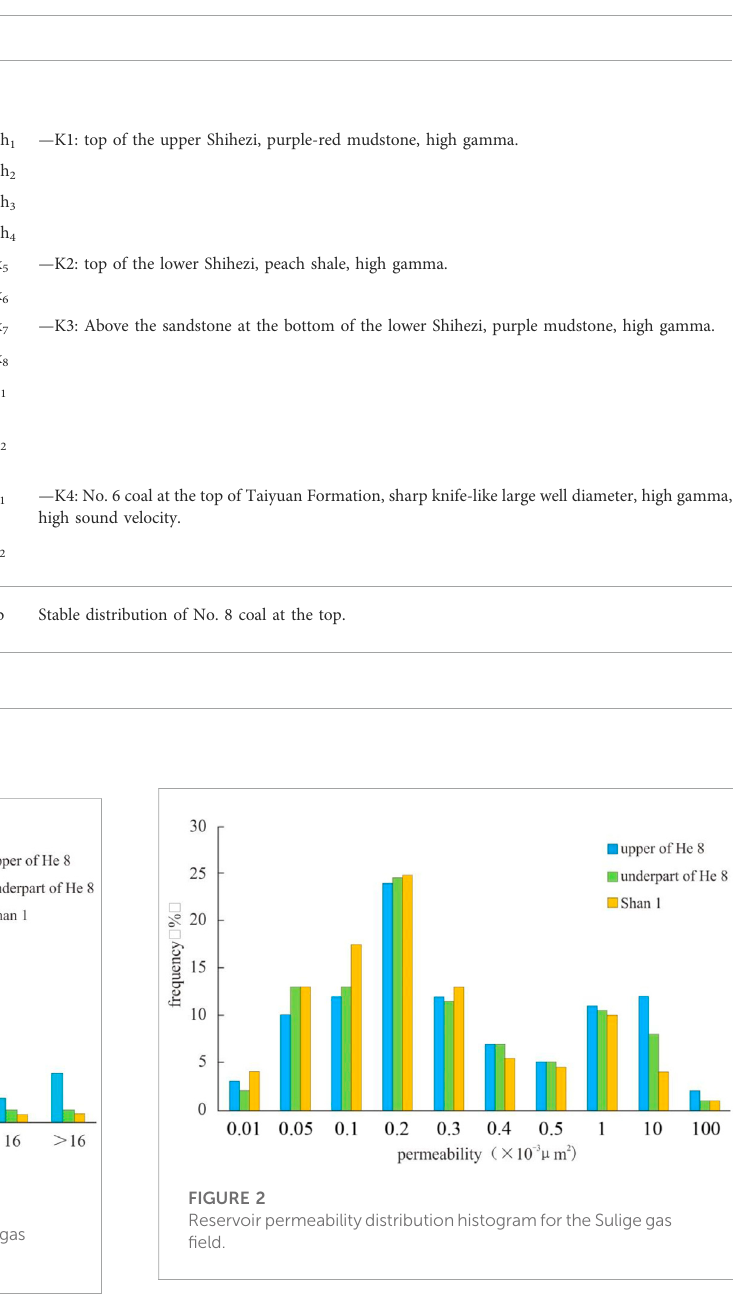
TABLE 1 Formation development situation of the Sulige gas fi eld, Ordos gas fi eld, and Ordos Basin.